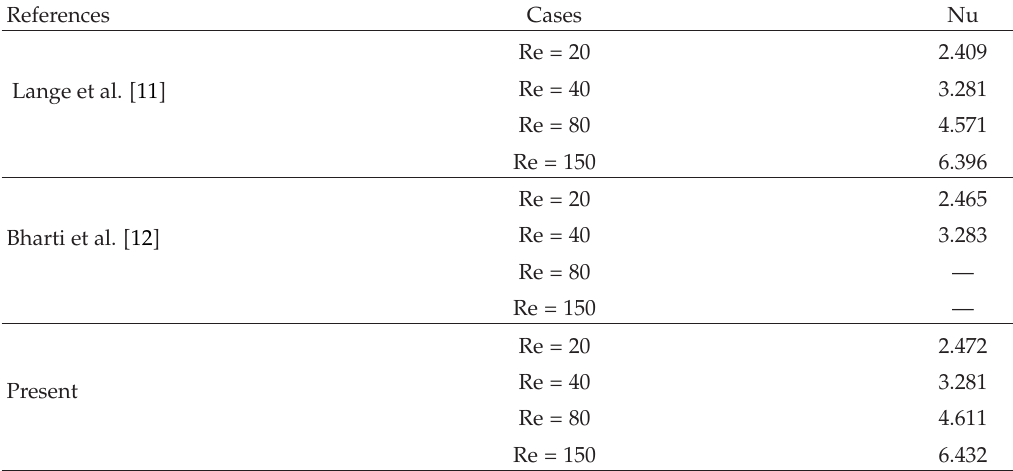
Table 1: Nusselt number comparison at di ff erent Reynolds numbers.